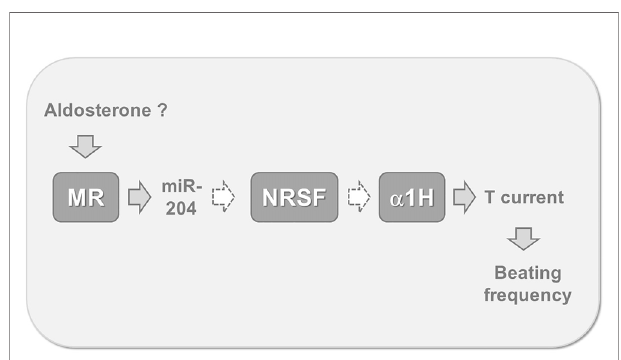
FIGURE 3 | Putative mechanism linking MR activation to increased myocyte beating frequency. Recent fi ndings suggest that cardiomyocyte MR stimulation, by aldosterone or other ligands, leads to the expression of miR- 204. This micro RNA reduces the translation of mRNA coding for NRSF, a speci fi c repressor maintaining low levels of alpha 1 H expression. This mechanism is globally responsible for T channel overexpression, for an increased inward T-type calcium current during the diastolic phase and therefore for the acceleration of spontaneous beatings. Gray arrows indicate stimulatory, while white dotted arrows indicate inhibitory steps. MR, cardiac mineralocorticoid receptor; miR-204, micro RNA 204; NRSF, neuron-restrictive silencing factor; a 1H, the alpha 1 subunit of the CaV3.2 T-type calcium channel; T current, calcium current supported by low threshold T-type calcium